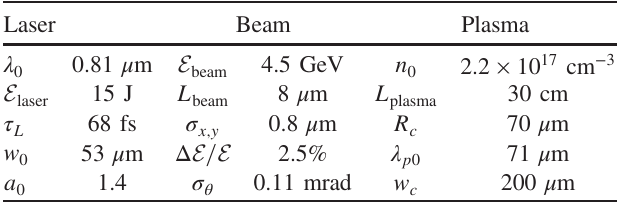
TABLE I. Simulation parameters. The first column contains laser pulse parameters: wavelength λ 0 , energy E , duration τ L , laser initial waist w 0 , and normalized amplitude a 0 . The laser is polarized in the y direction. The second column contains electron beam parameters: energy E , length L , widths σ x;y , energy beam beam spread Δ E = E , and divergence σ θ . The third column contains the plasma parameters: density n 0 , stage length L , channel plasma radius R c , plasma wavelength λ p 0 , and plasma width in the capillary w c . Widths are given as rms values, assuming Gaussian distributions for all quantities.